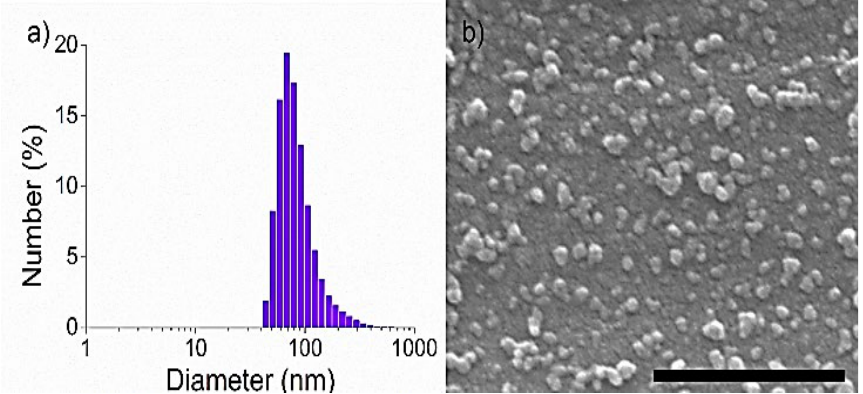
Figure 3. ( a ) Size distribution of RuBIS CPNs, measured using dynamic light scattering in PBS solution (average diameters of 50 ± 12 nm). ( b ) Representative SEM image of RuBIS CPNs, scale bar: 500